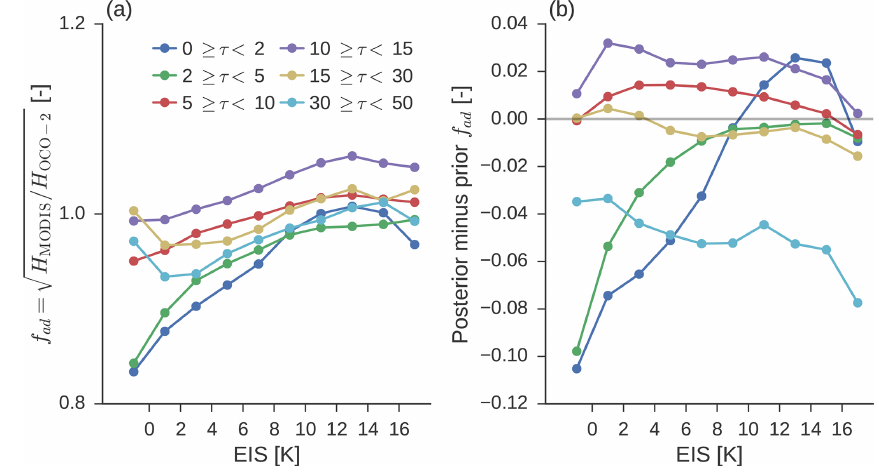
Figure 7. Estimated adiabatic fraction of OCO-2 Quality_flag = 0 retrieved clouds relative to MODIS, assuming equal liquid water paths and binned by estimated inversion strength. The first bin includes all cases where EIS < 0 ◦ C, and the last bin includes all cases where EIS > 16 ◦ C. (a) Posterior f ad split by cloud τ . (b) The change in OCO-2 f ad as posterior minus